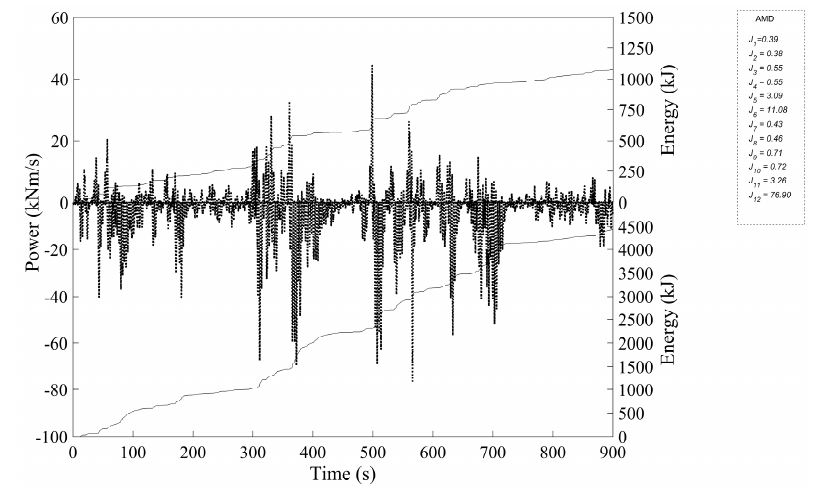
Figure 15. Power and its time integral (dotted line) energy of a purely active mass damper (AMD) system (no passive damping component) along with the corresponding performance indices. Positive stands for energy addition and negative for energy dissipation.